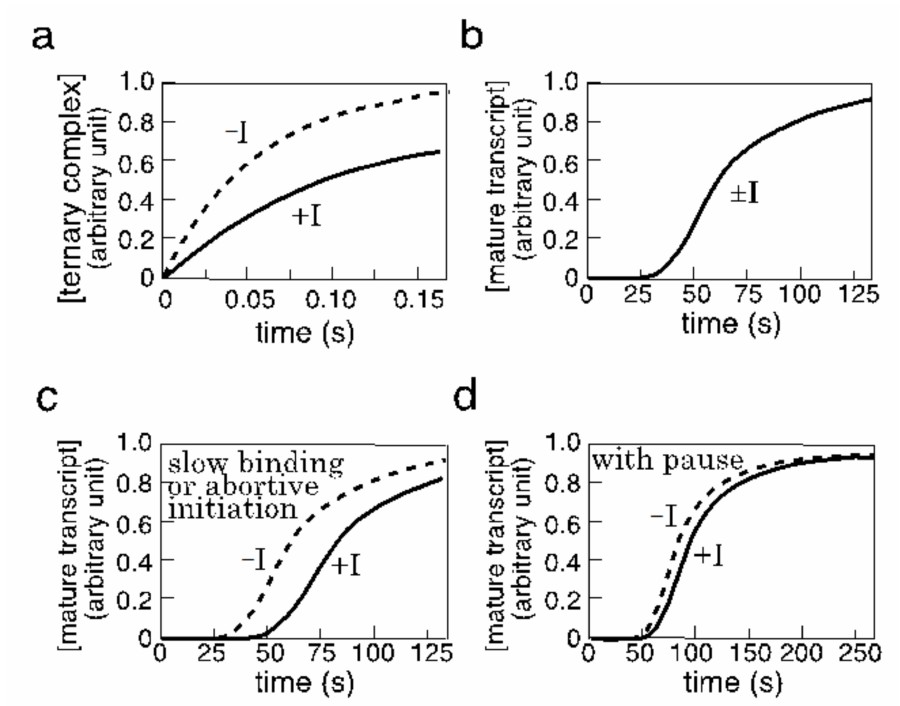
Figure 2. Competitive repressor binding and transcription inhibition. The time courses of ternary complex formation ( a ) and the production of the mature transcript ( b – d ) are shown in the case where the repressor (I) and RNAP (R) competitively bind to the promoter–operator overlapping domain of the DNA. The binding reactions are supposed to be rapid, if compared with subsequent reactions. These time courses are generally dependent on many experimental parameters, as well as RNA degradation, and are thus presented as example images. The scale of the coordinates, time, also symbolically indicates the differences between the timescales. ( a ) The addition of a repressor can significantly delay the formation of the ternary complex. The timescales are decreased by half in this example. ( b ) When the timescale of the formation mismatches that of the production of the mature product, the repressor cannot inhibit transcription. The two curves with or without the repressor almost overlap each other. ( c ) When slow binding or abortive initiation makes the timescale of the formation slower (longer), then the inhibition of ternary complex formation is reflected in the production of the mature transcript. ( d ) If an elongation pause is introduced, the mismatch is again recovered, and the inhibition is reduced. RNA processing can exert a similar effect to the